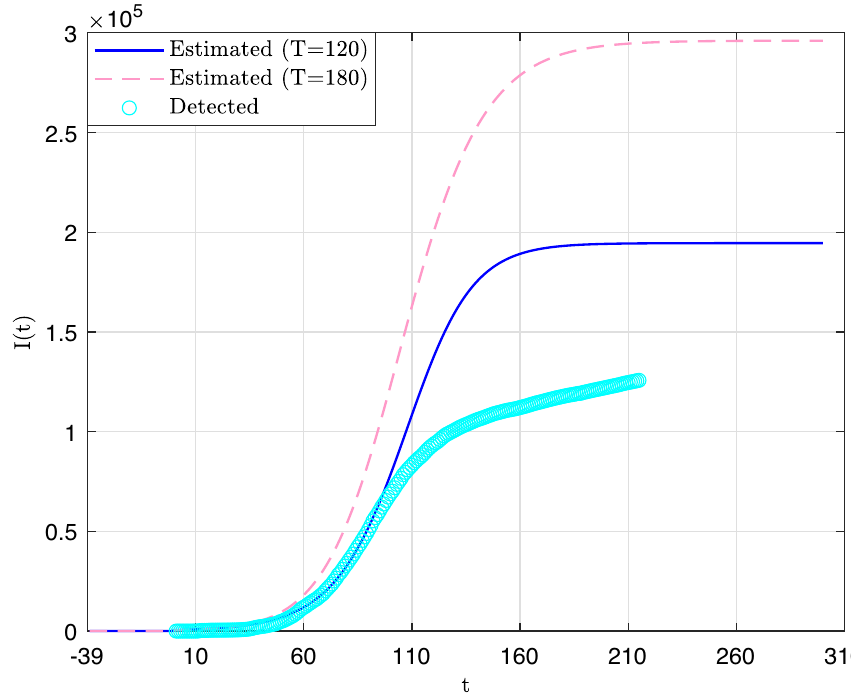
Figure 2. Estimate total number of infected cases curves.